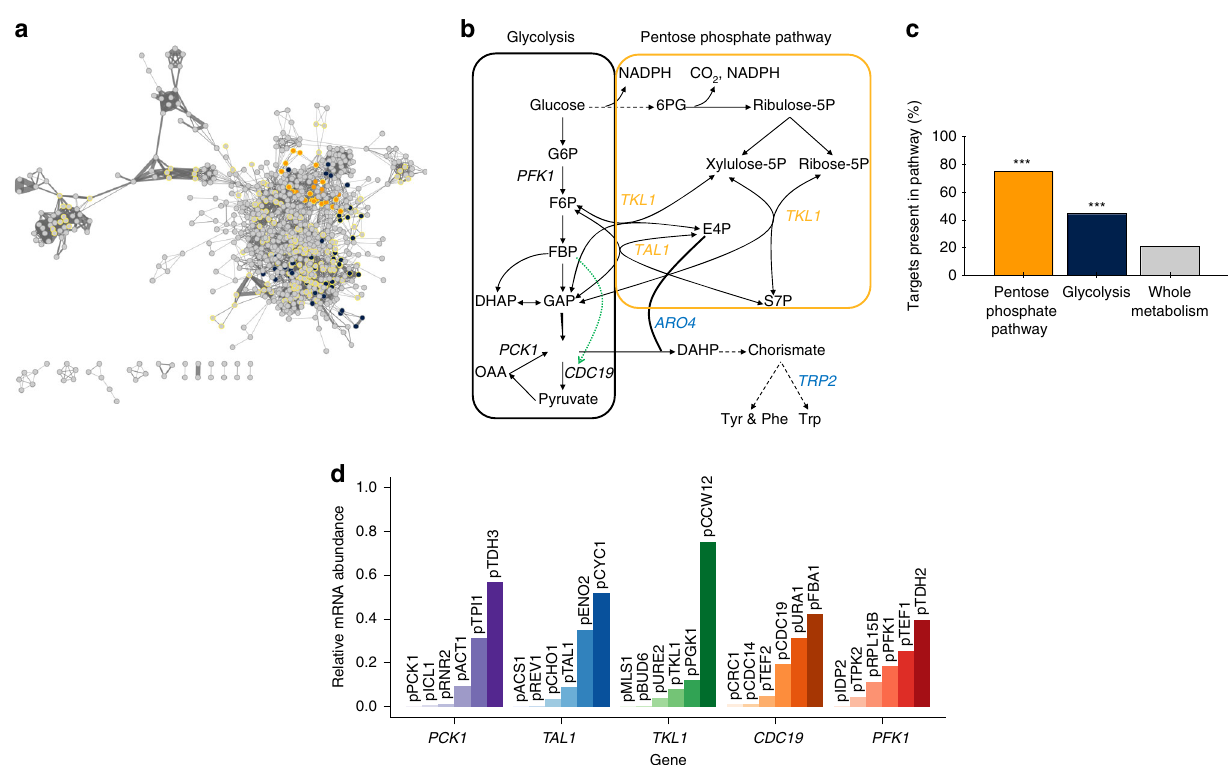
Fig. 1 Gene targets and promoters for combinatorial engineering of tryptophan metabolism in S. cerevisiae . a Gene – gene interaction network built with Cytoscape, showing that pentose phosphate pathway and glycolysis are both in the core of metabolism in close proximity to many genes. Nodes are all 909 genes in yeast metabolism 67 , sharing connections based on the number of shared metabolites by the corresponding reactions that the genes are related to: the thicker the edge, the higher the number of shared metabolites. Currency metabolites such as water, protons, ATP, etc. are removed from the analysis. The prefuse force directed layout is used for displaying the network. Genes are highlighted with a yellow border if they are selected targets by the mechanistic modeling approach, and in orange and dark blue if they belong to the pentose phosphate pathway or glycolysis, respectively. b Simpli fi ed map of metabolism showing the selected gene targets from glycolysis (dark blue) and pentose phosphate pathway (orange) based on a combination of mechanistic genome-scale modeling and literature studies for optimizing tryptophan production. Black dashed lines indicate multistep reactions. Dashed green line indicates allosteric activation. G6P glucose 6-phosphate, F6P fructose 6-phosphate, FBP fructose 1,6-bisphosphate, GAP glyceraldehyde 3- phosphate, DHAP dihydroxyacetone phosphate, PEP phosphoenolpyruvate, OAA oxaloacetate, 6PG 6-phosphogluconate, E4P erythrose 4-phosphate, S7P sedoheptulose 7-phosphate, DAHP 3-deoxy-7-phosphoheptulonate, Tyr tyrosine, Phe phenylalanine, Trp tryptophan. c Percentage of genes in glycolysis (dark blue) and pentose phosphate pathway (orange) that were predicted by the mechanistic modeling to increase tryptophan production compared to the percentage of genes predicted as targets from the whole metabolism. *** P -value < 0.05, two-sided Fisher ’ s exact testing with n = 54 and 24 for the glycolysis and pentose phosphate pathway, respectively. d Relative messenger RNA (mRNA) abundance, calculated for each gene as the proportion of mRNA reads obtained for any given promoter relative to the total sum of mRNA reads from each bin of six promoters. Absolute abundances for the 30 promoters were measured in S. cerevisiae CEN.PK113-7D in the mid-log phase 32 . The promoters are grouped according to intended combinatorial gene associations. Source data underlying Fig. 1d are provided as a Source data fi